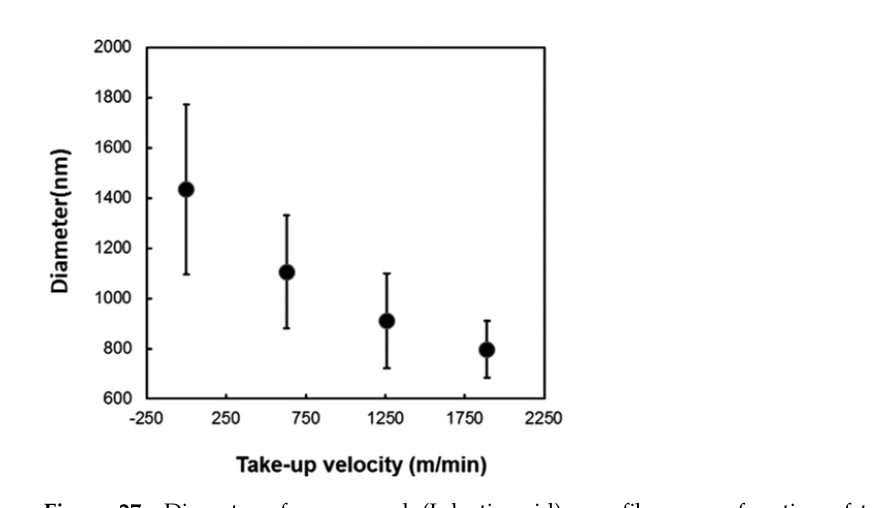
Figure 27. Diameter of porous poly(L-lactic acid) nanofibers as a function of take-up velocity. Reproduced from [181] with the permission of Elsevier.